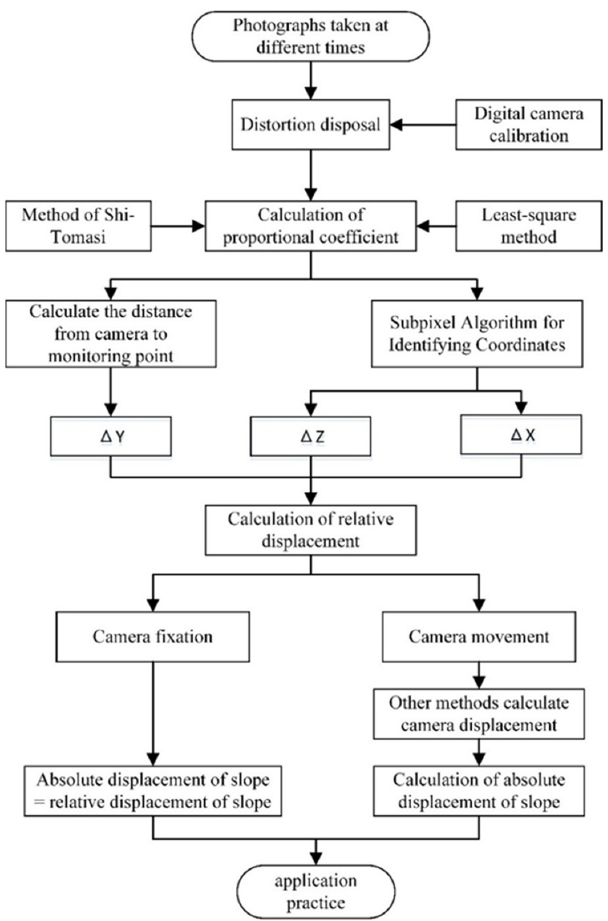
Figure 2. Flow chart illustrating the experiment.